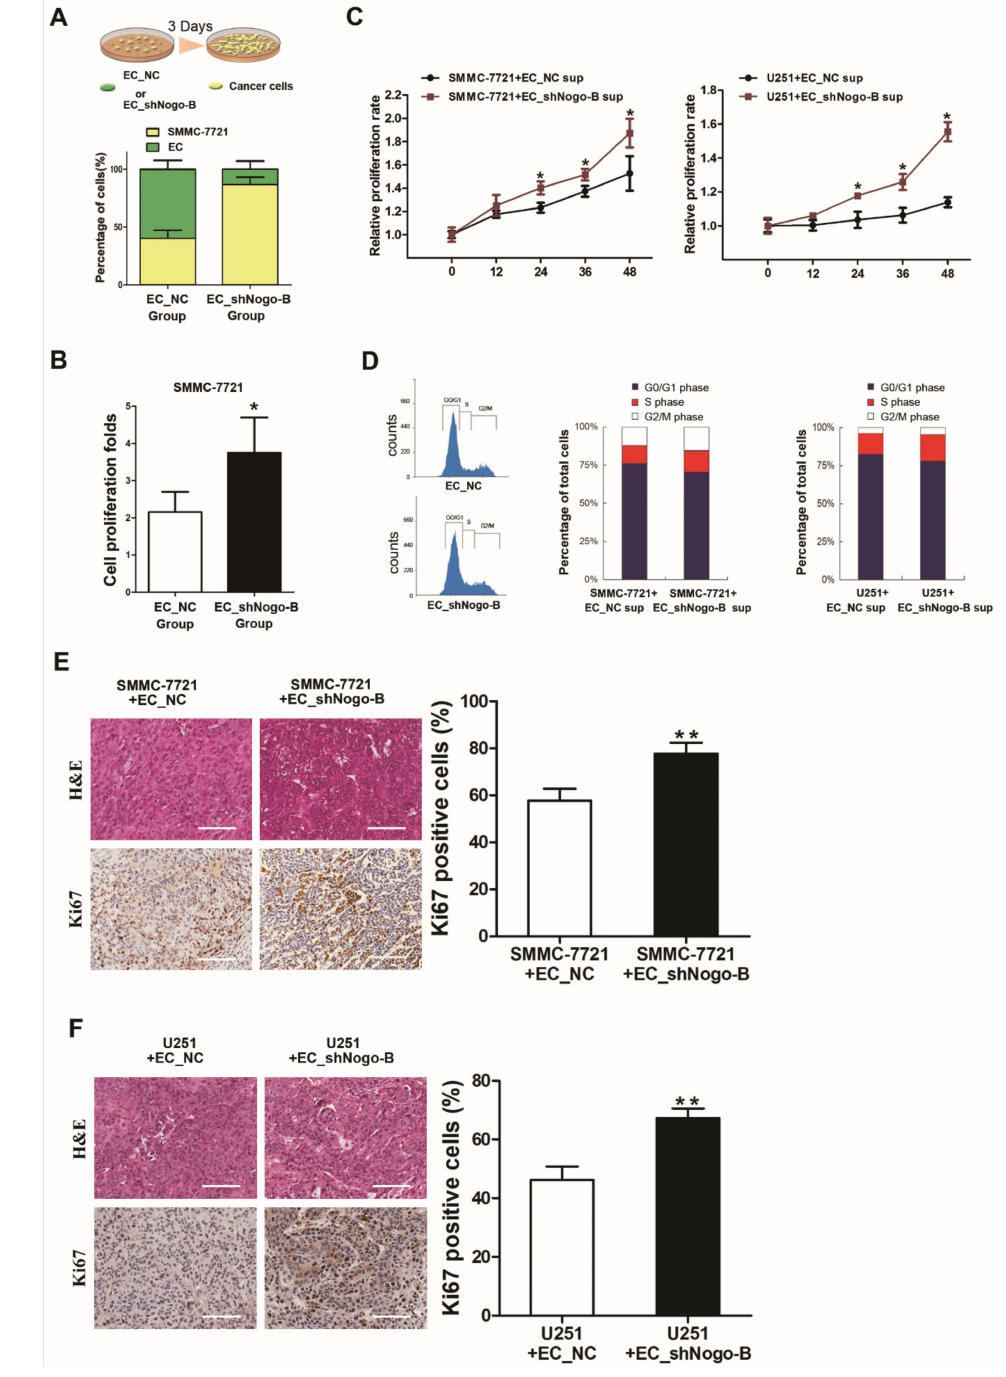
Figure 4. Reduced endothelial Nogo-B expression inhibits the proliferation of cancer cells. ( A ) SMMC-7721 cells were co-cultured with an equal number of CFSE-labeled EC_shNogo-B